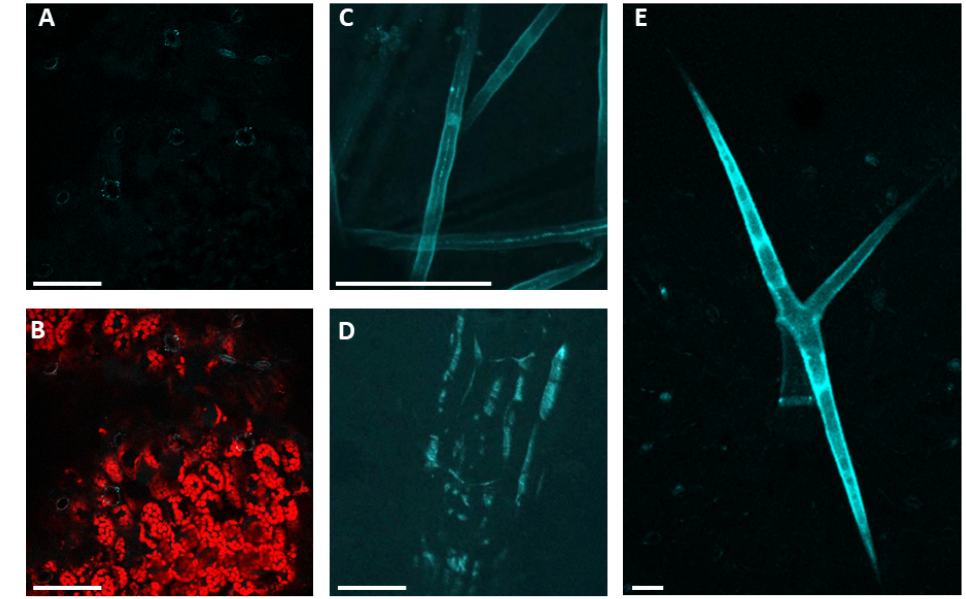
Figure 4 – RcDGAT3 accumulates in A. thaliana epidermal cells. Confocal fluorescence microscopy images from different tissues of transgenic A. thaliana plants expressing 35S::DGAT3-CFP. (A) Arabidopsis leaf; (B) Same image as (A) with overlaid chlorophyll autofluorescence; (C) Root hairs and (D) Root epidermis, (E) Trichome. Scale bars = 50